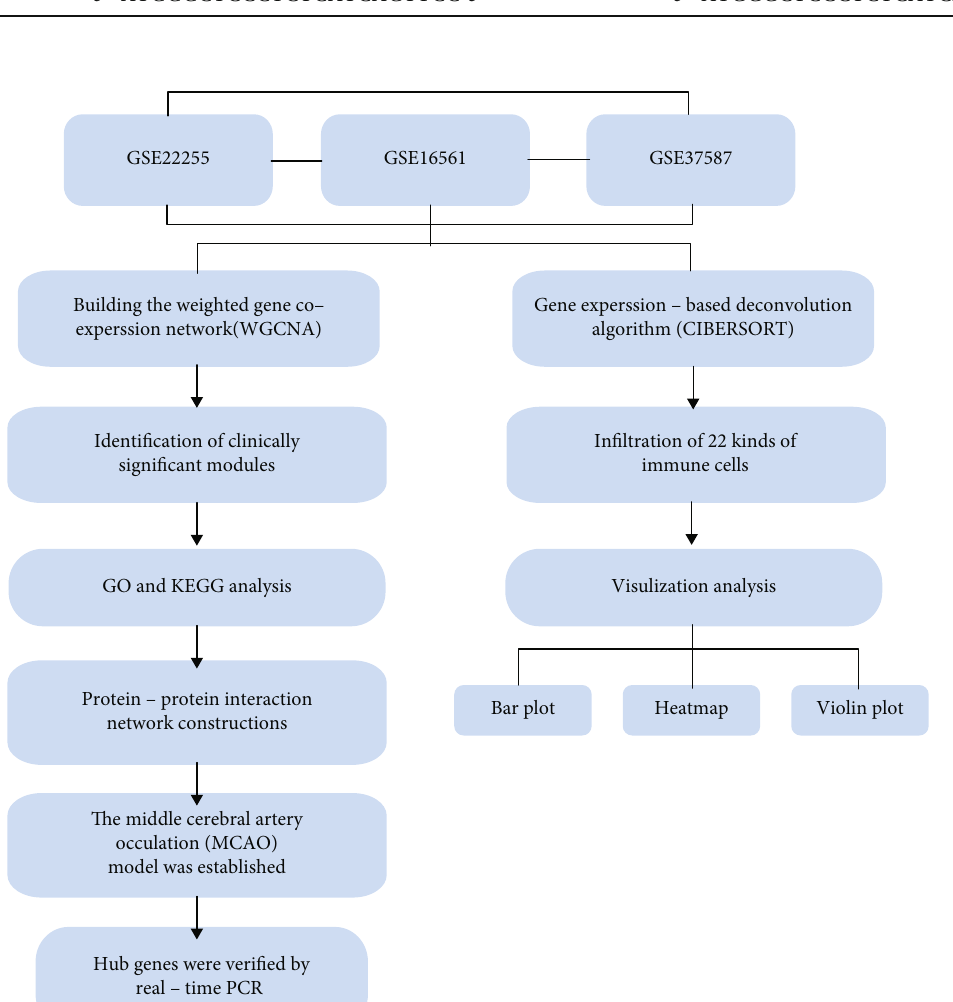
Figure 1: The work fl ow of the whole